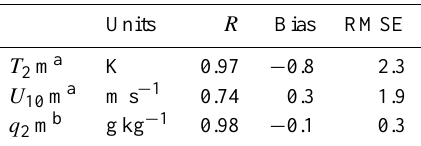
Table 1. Comparison statistics between RACMO2 and observations presented by Ettema et al. (2010a). Shown are annual mean 2m temperature ( T 2 m), 10m wind speed ( U 10 m) and 2m specific hu- midity ( q 2 m).